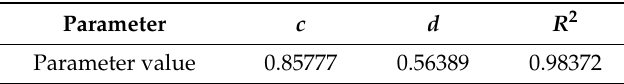
Table 5. Fitting results of PD mathematical model.